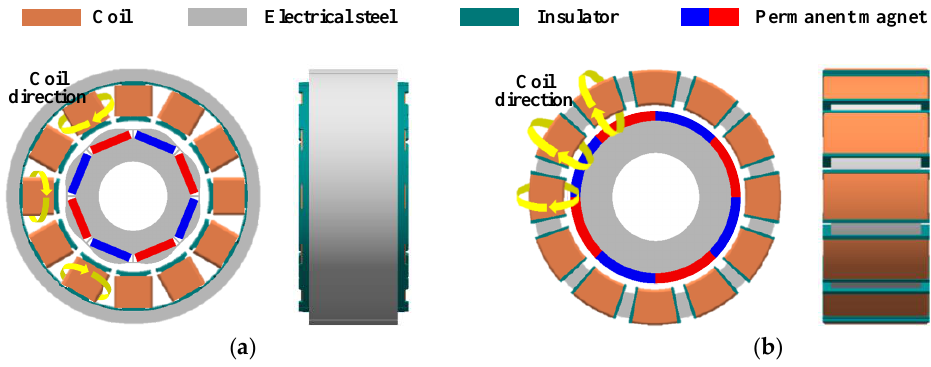
Figure 1. Motor structure: ( a ) Conventional motor, and ( b ) Slotless motor with toroidal winding. As such, cogging torque is inevitably generated due to the fundamental teeth and slot structure of the CM. The generated cogging torque not only causes vibration and noise, but also adversely affects speed and position control during low-speed operations